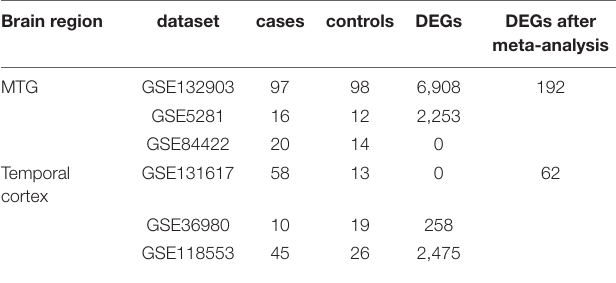
TABLE 3 | Datasets used in the